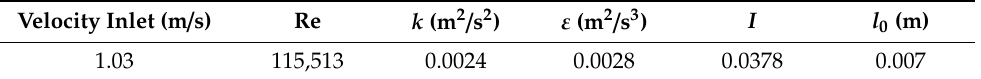
Table 1. The parameter values of the pipeline liquid.